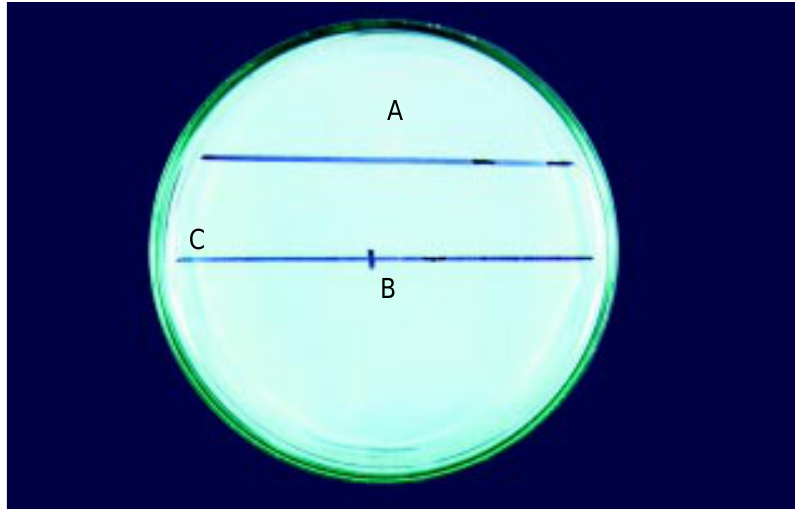
Figure 1 - Photo of a Petri dish that shows: A , area where the drug is placed; B , center and diameter and C , 0-degree